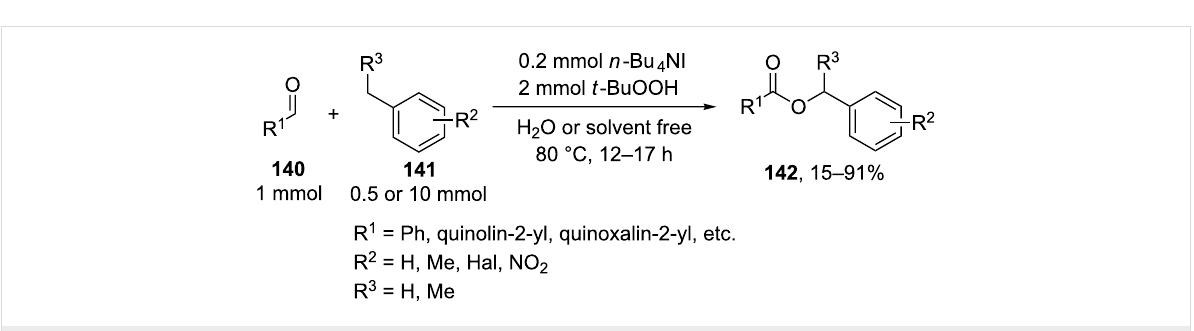
tert -Butyl peresters 144 were synthesized on a preparative